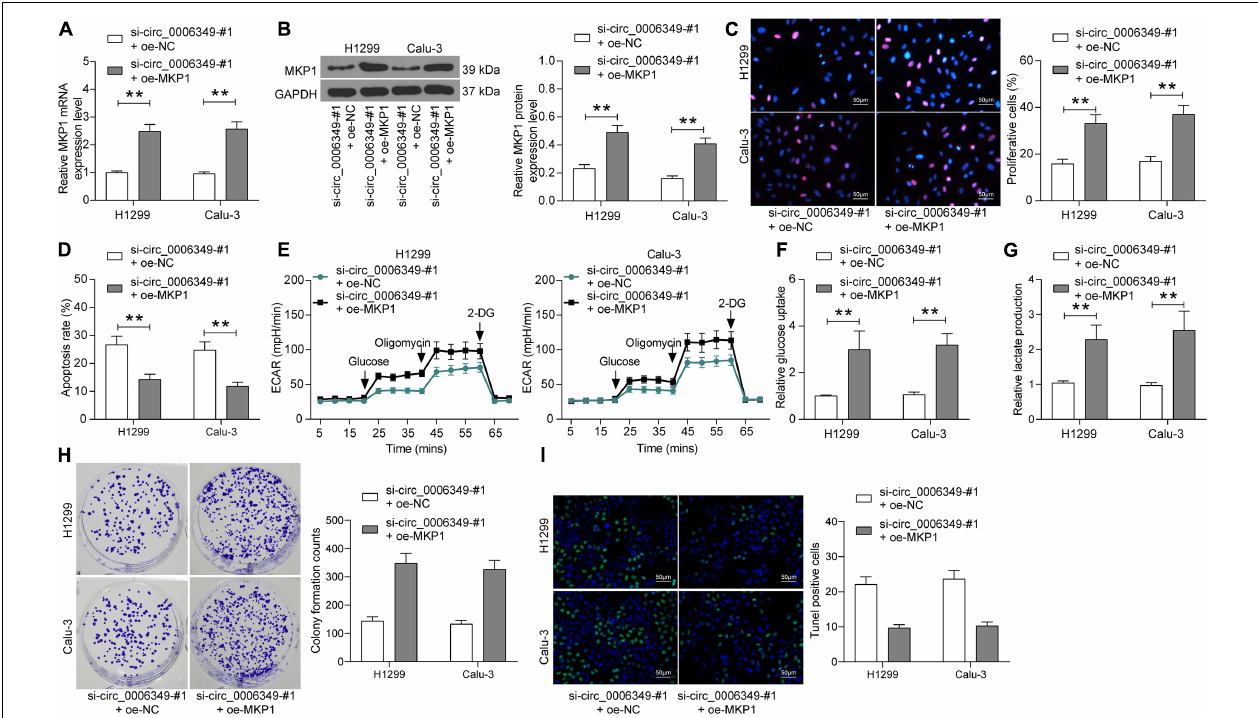
FIGURE 7 | Overexpression of MKP1 promotes the malignant behaviors of NSCLC cells. (A,B) transfection efficacy of oe-MKP1 in H1299 and Calu-3 cells validated by RT-qPCR and western blot analysis, respectively; (C) DNA replication activity of H1299 and Calu-3 cells measured by EdU labeling assay; (D) apoptosis of H1299 and Calu-3 cells detected by the flow cytometry; (E) ECAR in H1299 and Calu-3 cells; (F,G) glucose uptake (F) and lactate production (G) in H1299 and Calu-3 cells; (H) colony formation ability of H1299 and Calu-3 cells examined by the colony formation assay; (I) apoptotic bodies in H1299 and Calu-3 cells examined by the TUNEL assay. Differences were compared by two-way ANOVA (A–D,F–I) . All data were presented as the mean ± SD from three independent experiments. ** p < 0.01.